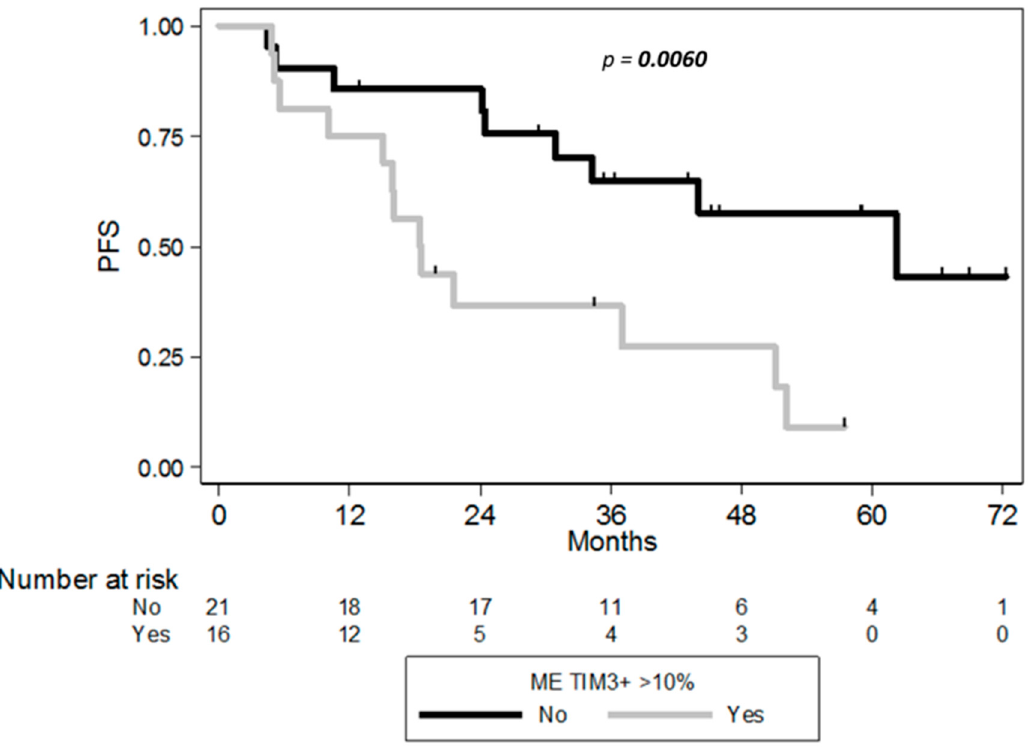
Figure 5. Progression Free Survival (PFS) curves according to the percentage of TIM-3 + ME cells of cHL patients ( n = 37), with cutoff of 10% of ME immune cells positive ( p = 0.006).